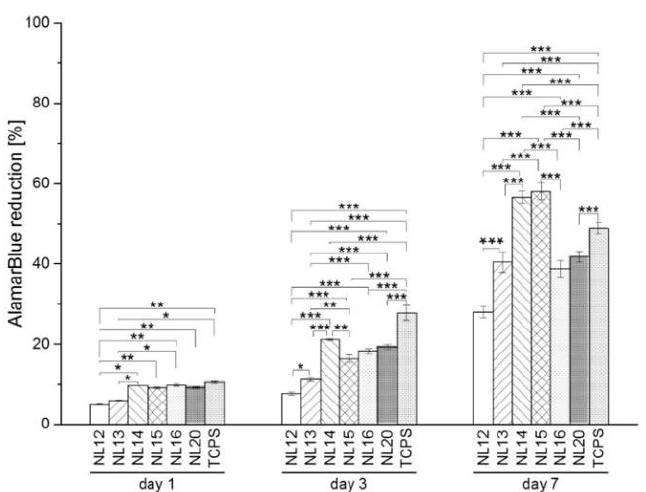
Figure 12. Metabolic activity of MG-63 cells cultured on di ff erent polymers and control TCPS measured by AlamarBlue test. Asterisks show statistical significance made with Fisher’s LSD test; p* < 0.05, p** < 0.01, p*** < 0.001.